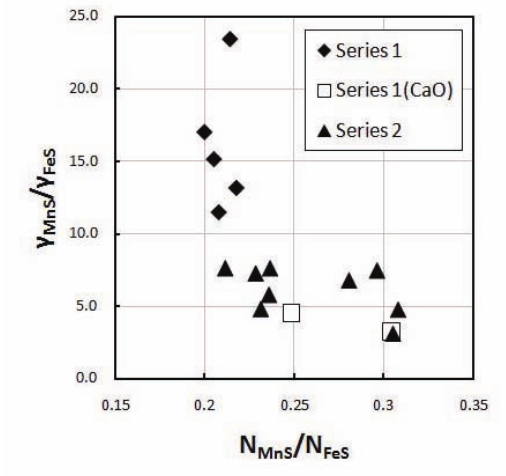
Figure 14. Relationship netween the ratio of .(cid:3) MnS =(cid:3) FeS / and that of .N MnS =N FeS / in